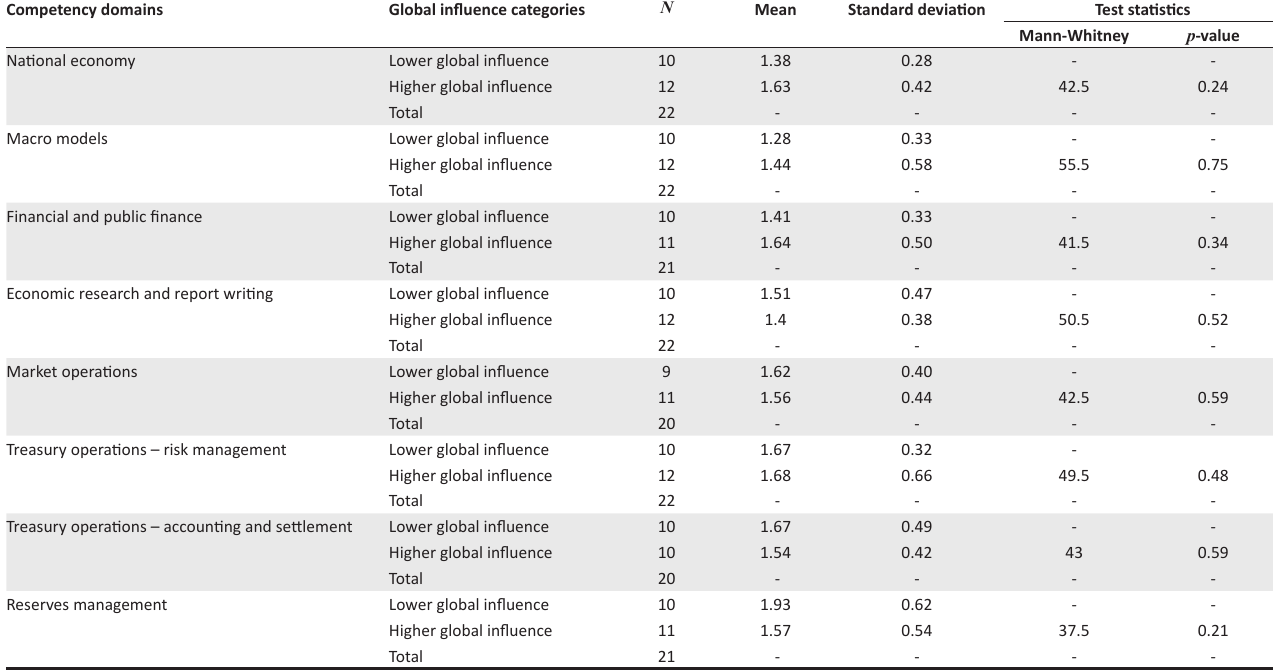
TABLE 7: Hypothesis testing: The level of global influence with respect to the competency model in use – results of the Mann-Whitney u